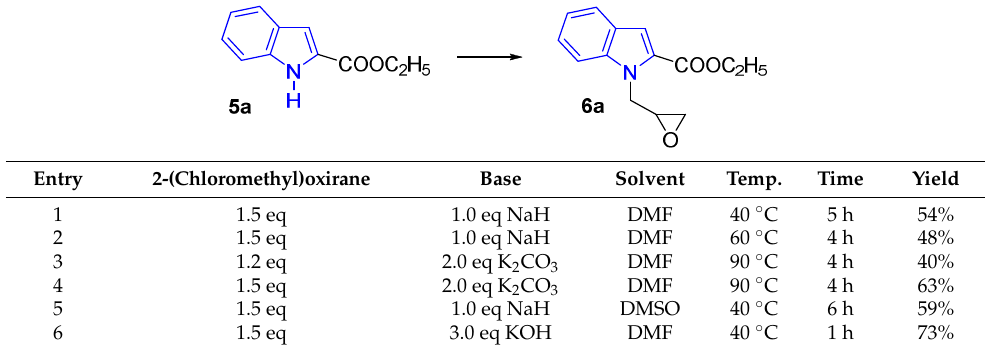
Table 2. Optimization of reaction conditions between 5a and 2-(chloromethyl)oxirane.